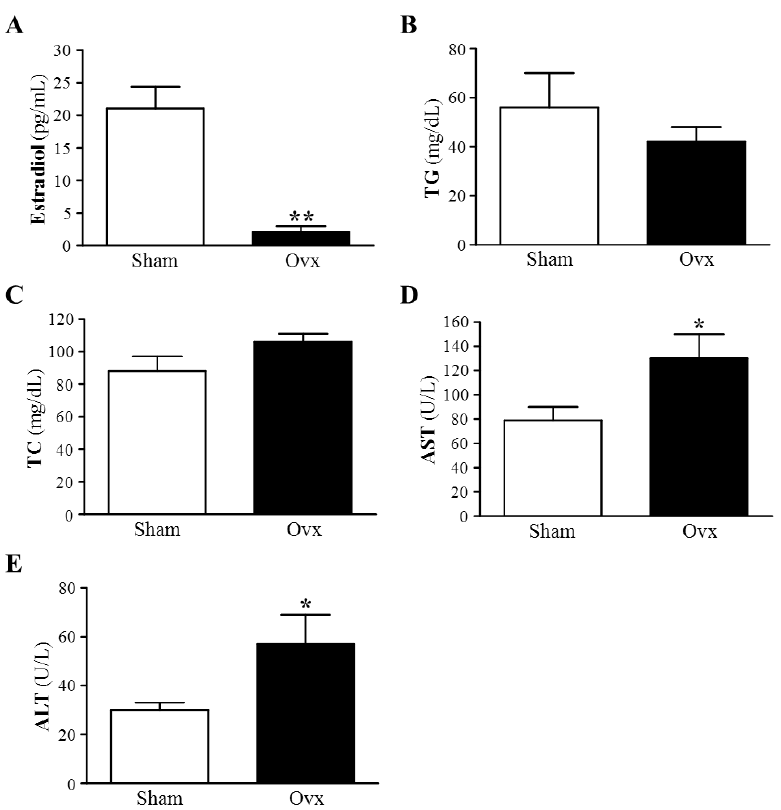
Figure 1. Effect of Ovx on plasma estradiol ( A ), TG ( B ), TC ( C ), AST ( D ) and ALT ( E ) levels at four months after ovariectomy. Mean ± SEM ( n = 8). * p < 0.05 and ** p < 0.0001 vs . Sham, respectively.